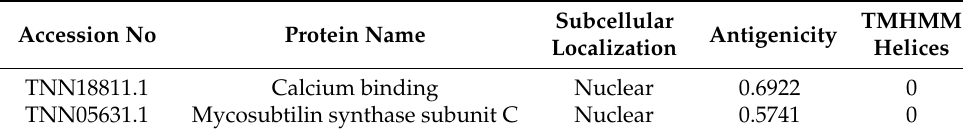
Table 1. Details of the Schistosoma vaccine candidates.